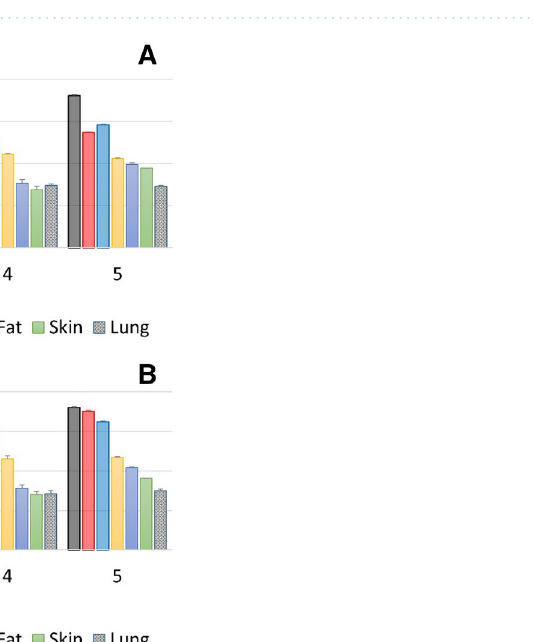
Figure 1. ( A ) Basic structure. ( B ) Photograph of pleural cavity recognition system.